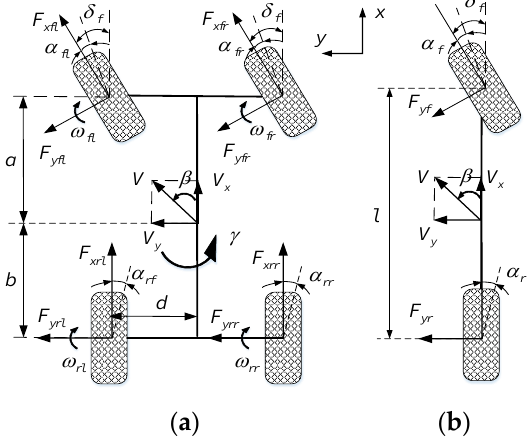
Figure 2. Dynamic models of the 4MIDEV. ( a ) 3-DOF model. ( b ) 2-DOF model.